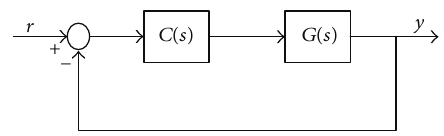
Figure 1: Block diagram of the unity feedback control